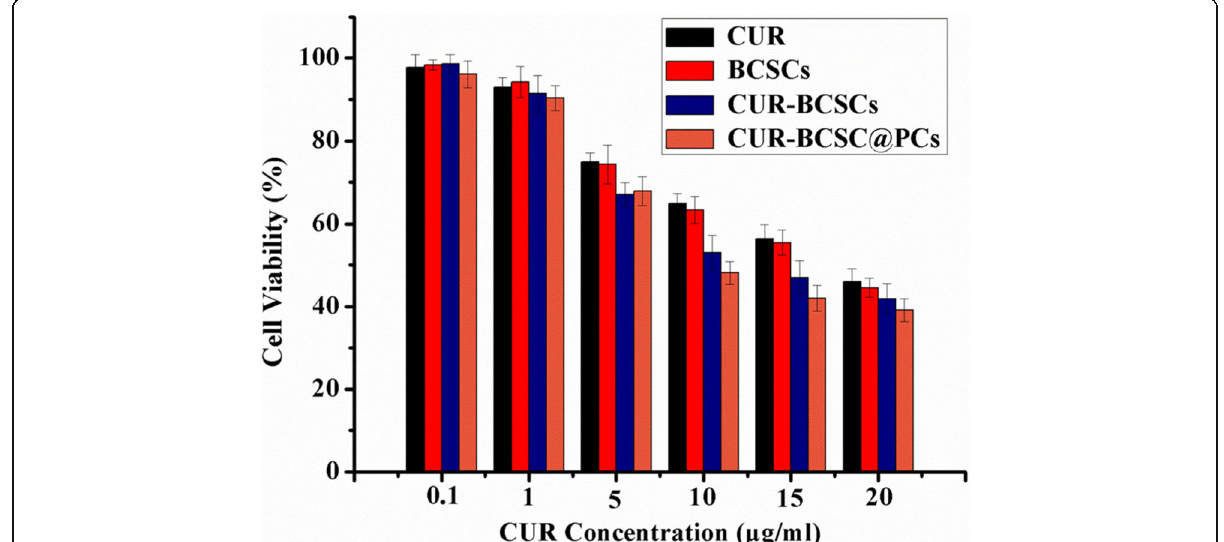
Fig. 8 In vitro cytotoxicity of different formulations at 24 h in A549